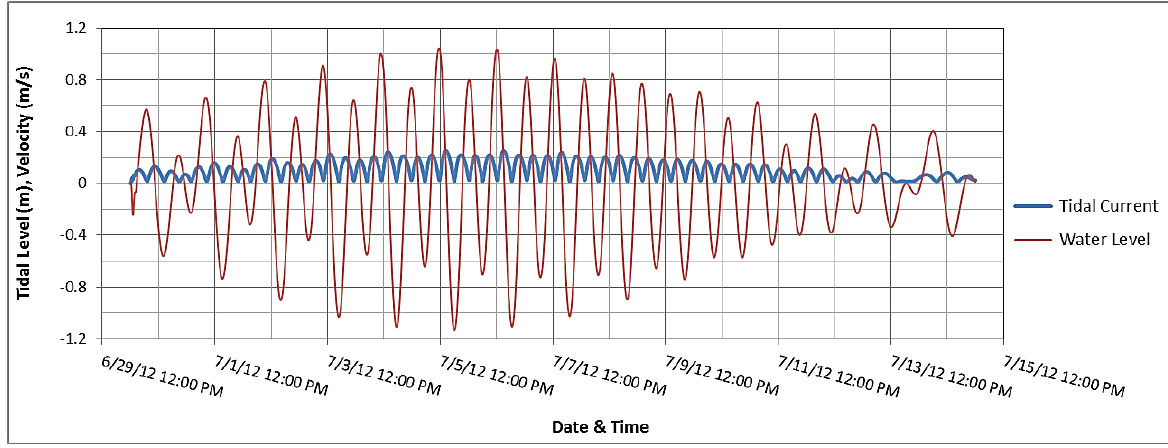
Figure 4. Variation of tidal water level and current near the site over a neap-spring cycle.